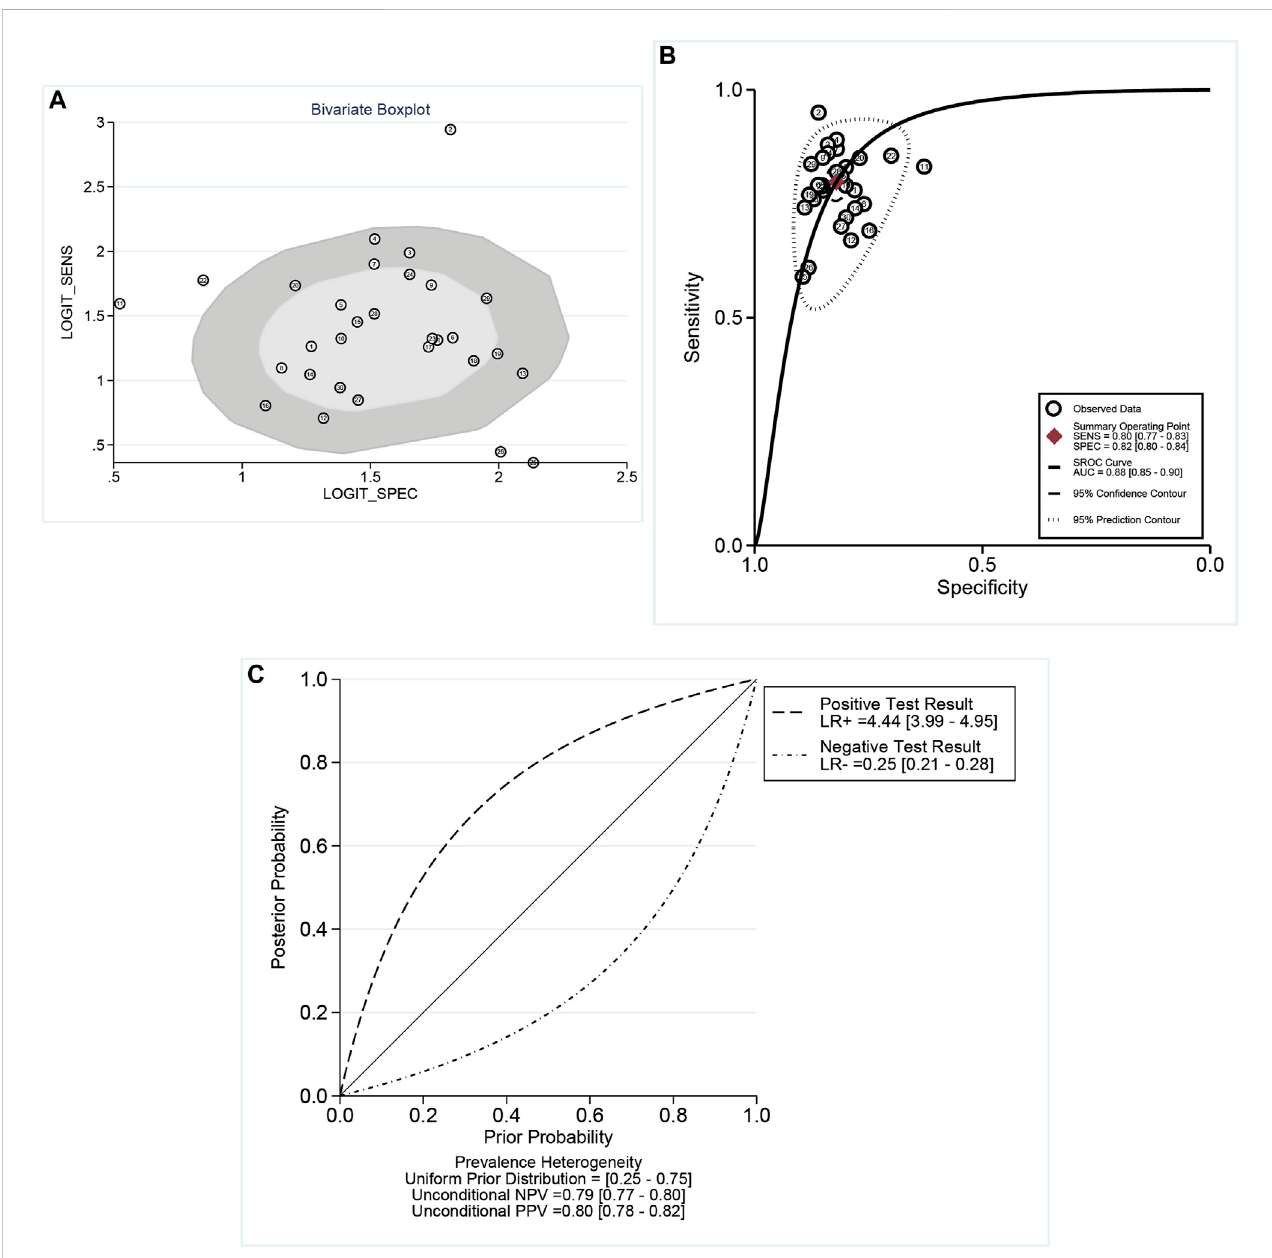
FIGURE 1 (A) Bivariate boxplot indicated the dispersion of datasets as an indicator of heterogeneity. (B) Summary receiver operator characteristic (SROC) curves. AUC, area under the curve; SENS, sensitivity; and SPEC, speci fi city. (C) Conditional plot: the overall results for NPV, PPV, LR + , and LR − . According to the bivariate boxplot, signi fi cant heterogeneity was observed among studies. I 2 values of heterogeneity analysis resulted in 97.33 for sensitivity and 88.64 for speci fi city, which showed signi fi cant heterogeneity. The SROC curve showed that the values of sensitivity and speci fi city were 0.80 and 0.82,